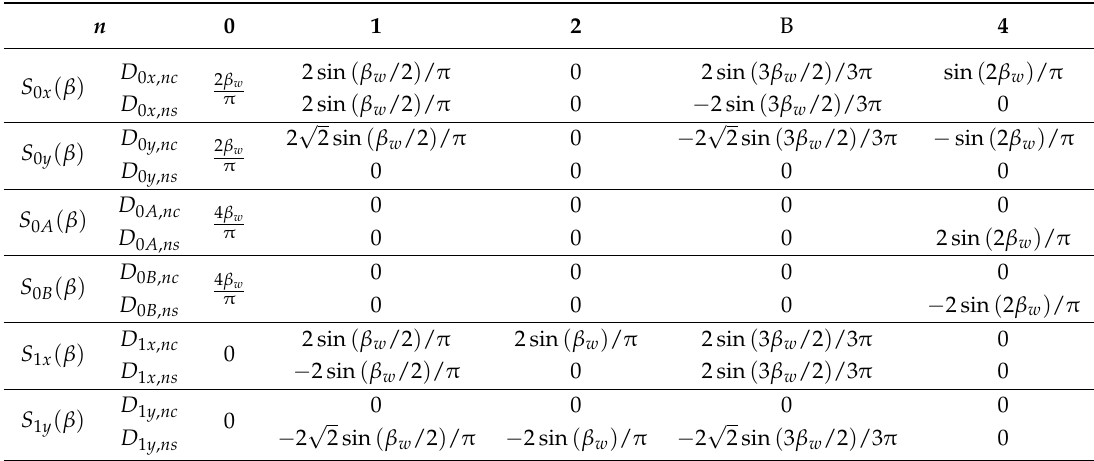
Table 6. Fourier coefficients of S i ( β ) for the differential electrode arrangement of MHRs.